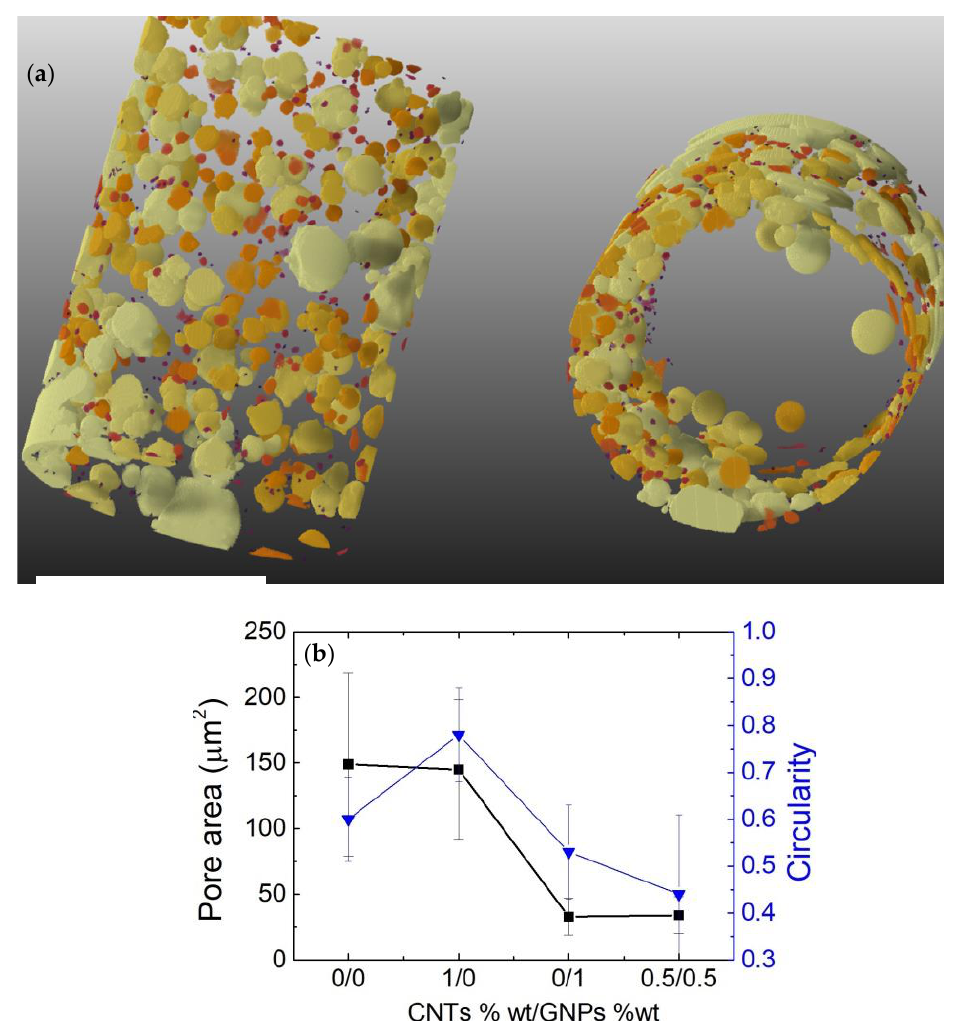
Figure 5. ( a ) Snapshots of μ -CT analysis showing the volume distribution of the bubbles around the hollow middle cylinder. The scale bars indicate 10 mm. ( b ) Pore area and circularity data of the pores as a function of the CNTs/GNPs weight ratio.